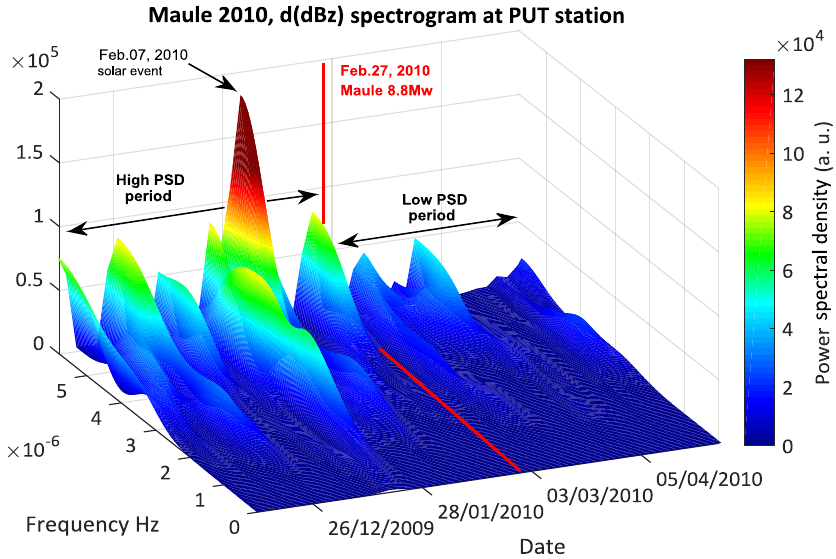
Figure 6. Spectrogram of Bz second temporal derivative. The Maule event date is marked in red, where the period before the earthquake event is characterized by high power spectral density values (red colors) and the values after the earthquake are clearly lower (blue colors). The February solar event is also marked (Dröge et al.,